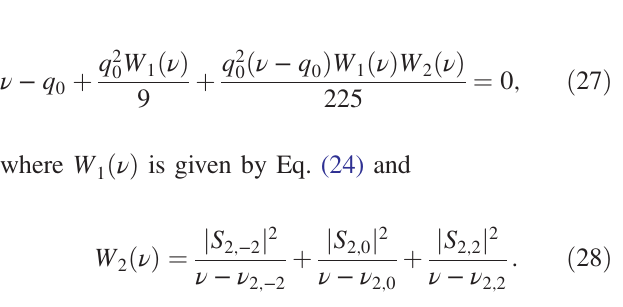
FIG. 5. Threshold curve of the boxcar bunch in different approximations. The index n means maximal power of the max Legendre polynomial in the expansion. The left-hand line shows the TMCI threshold, and the right-hand rising lines are unphys- ical because of an absence of the